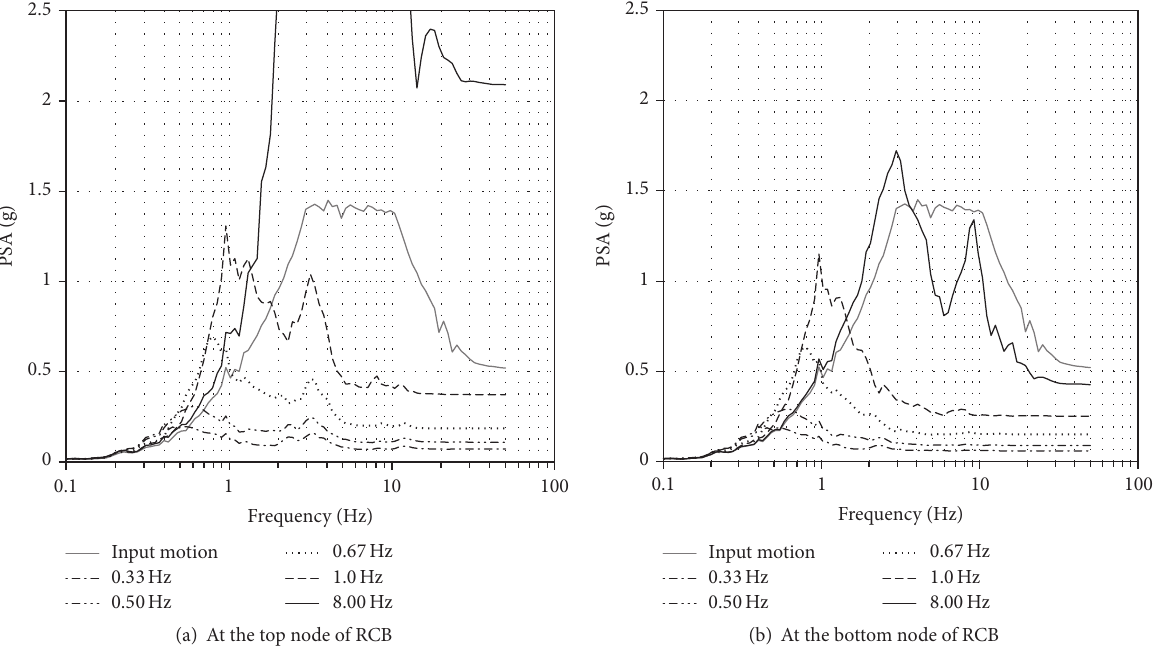
Figure 15: Effect of changing horizontal equivalent stiffness of bearings on